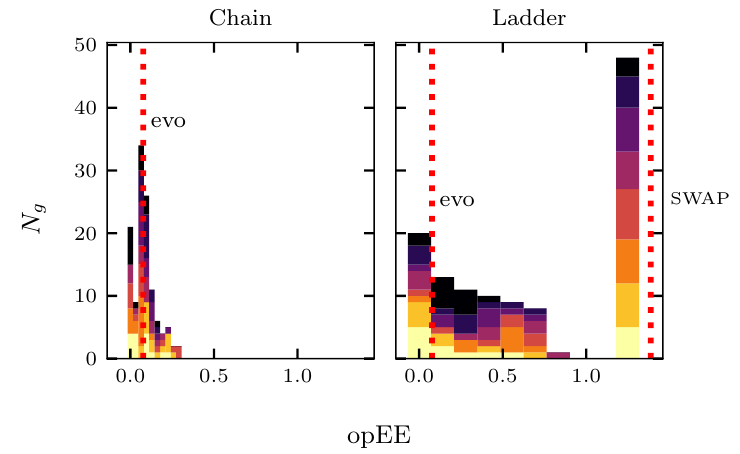
Figure 11: Stacked histograms for the opEE of the gates of a compressed circuit with depth M = 8, optimized at t = 2 for a L = 16 chain (left panels) and ladder (right panels). The colors denote the contents of each layer, with the lightest color for the bottom layer and the darkest for the top layer. The red vertical lines denote the values for the gates in a M = 8 first-order Trotter circuit, with the two lines in the ladder plots corresponding to the evolution and SWAP